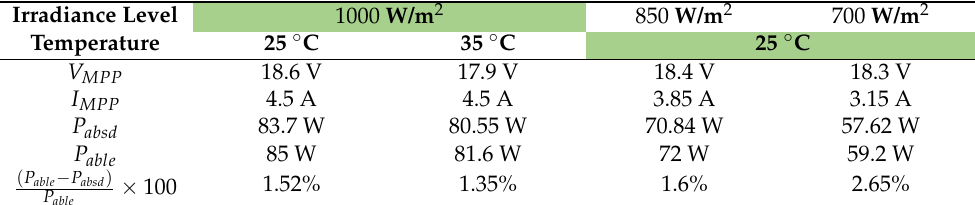
Table 3. Simulation results of the SMC-PCPV.